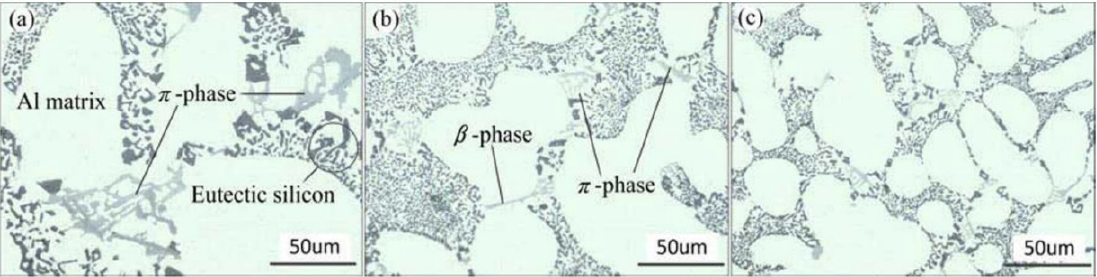
Figure 5. AlSi7Mg0.3 with 0.15 wt.% Fe sand casting at different cooling rate: ( a ) 0.19 °C/s; ( b ) 0.65 °C/s; and ( c ) 6.25 °C/s. Reproduced from [57] with permission from Elsevier, 2022.